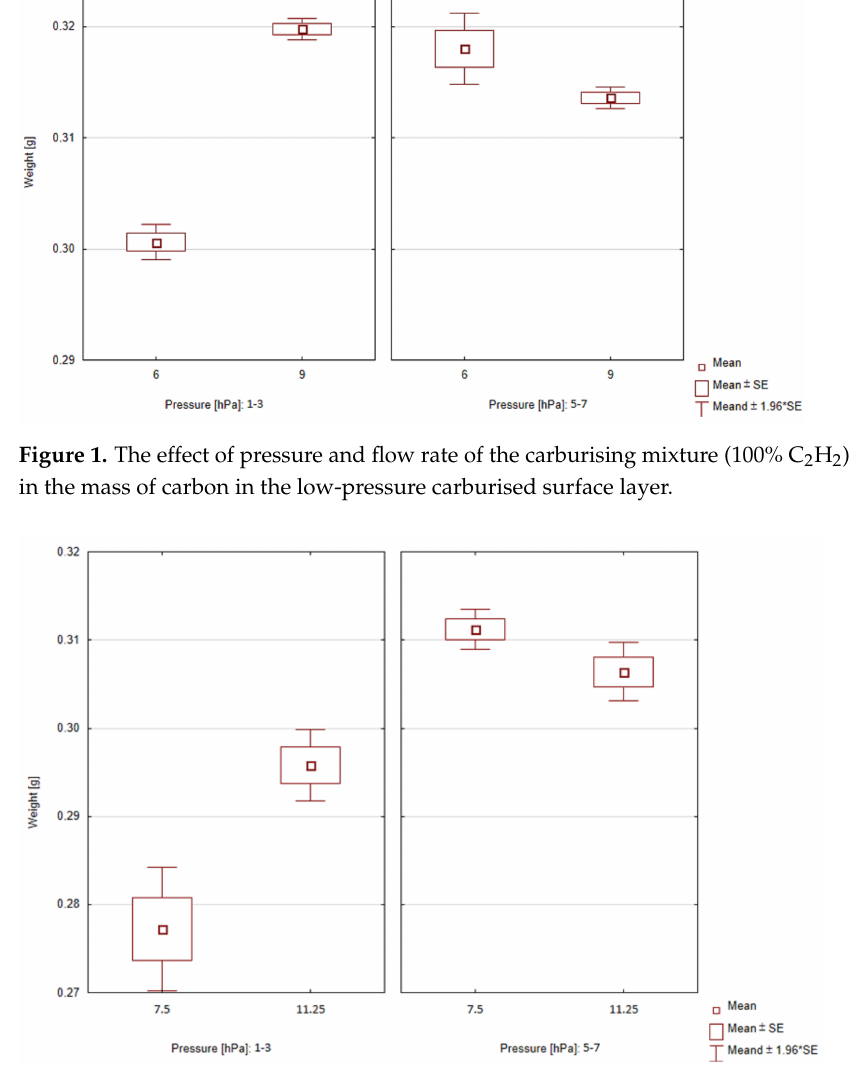
Figure 2. The effect of pressure and flow rate of the carburising mixture (C 2 H 2 :C 2 H 4 :H 2 ) on the increase in the mass of carbon in the low-pressure carburised surface